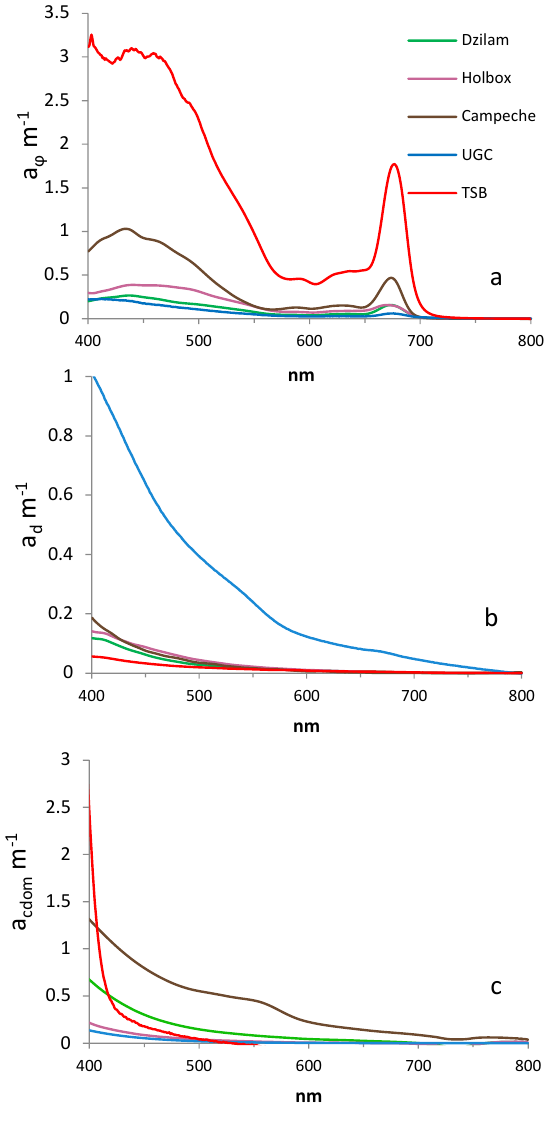
Figure 3. Absorption coefficients ( 𝑎(𝜆) ): ( a ) phytoplankton; ( b ) detritus and ( c ) colored dissolved organic matter (CDOM) of sampling points in active bloom for each sampling campaign (Dzilam, Holbox, Campeche Bay, Upper Gulf of California (UGC) and Todos Santos Bay